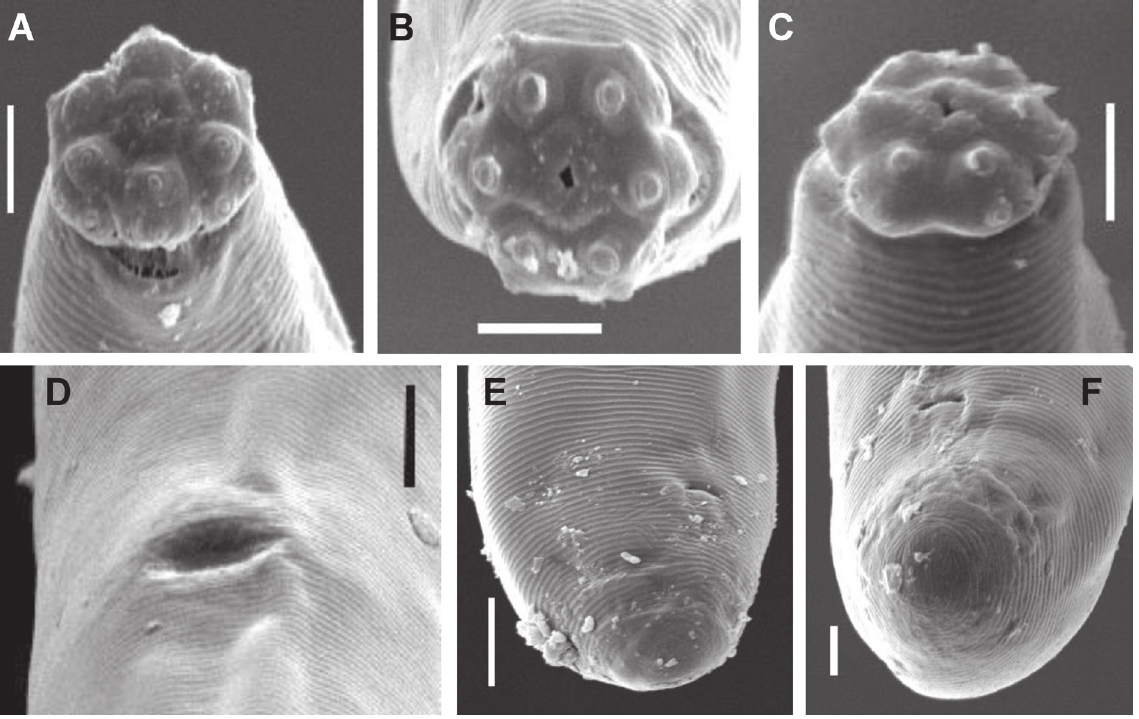
Fig. 4. Pungentus engadinensis (Altherr, 1950) (SEM). A . Lip region in lateral view. B . Same in frontal view. C . Same in ventral view. D . Vulva in ventral view. E-F . Caudal region in ventral view. (Scale